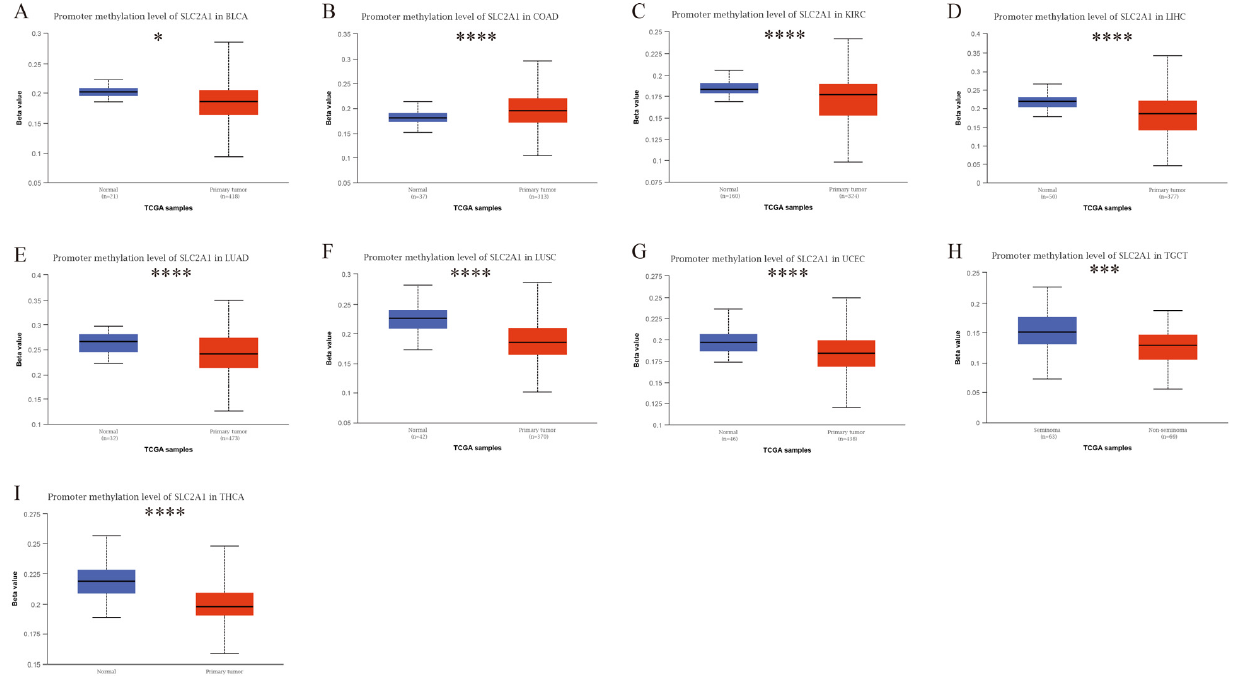
Figure 9. Promoter methylation level of SLC2A1 in pan-cancer: BLCA ( A ), COAD ( B ), KIRC ( C ), LIHC ( D ), LUAD ( E ), LUSC ( F ), UCEC ( G ), TGCT ( H ), and THCA ( I ) (*, p < 0.05; ***, p < 0.001; ****, p < 0.0001).